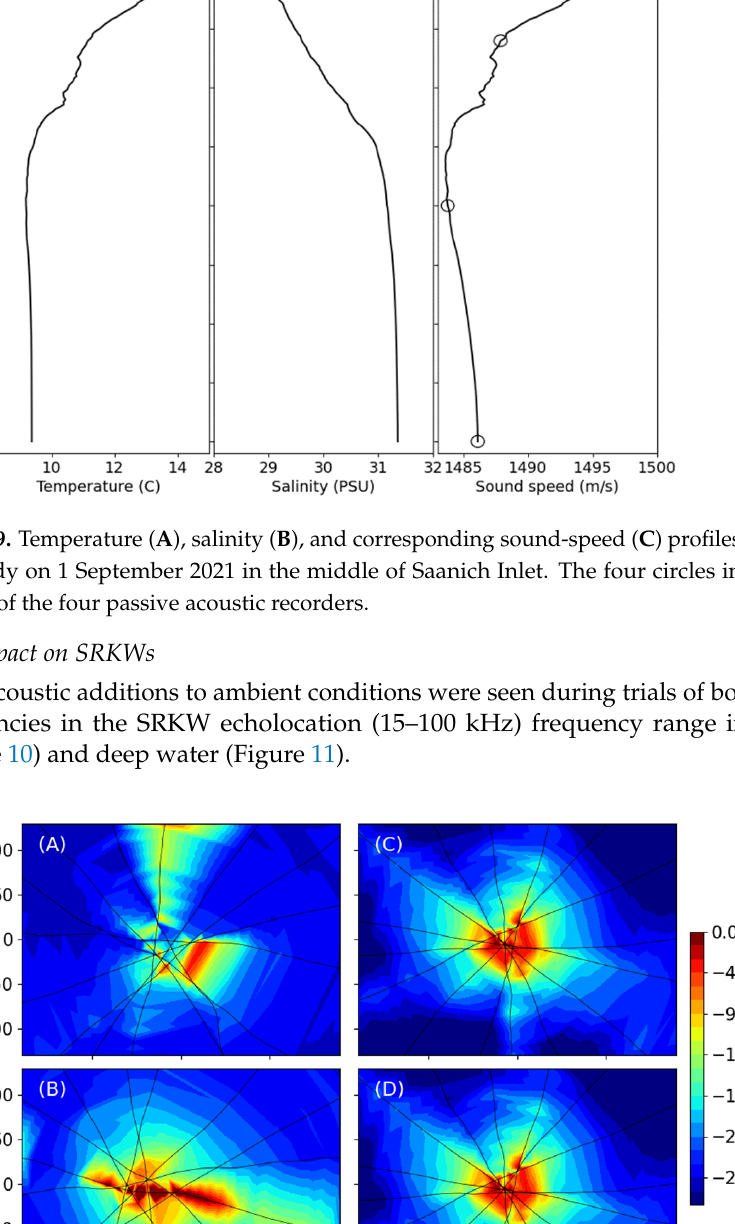
11 of 18 Figure 8. Temperature ( A ) and salinity ( B ) profiles measured during the four experimental periods in 2021. The profiles from 14 July and 16 and 25 August were taken in a shallow-water setting, and that on 1 September was taken in the upper 30 m of the deep-water setting. Sound-speed profiles